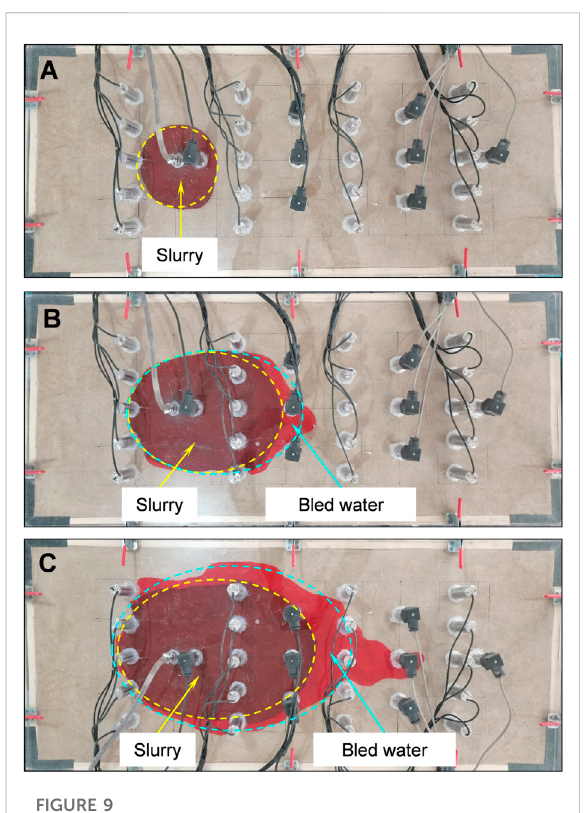
FIGURE 9 Distribution of slurry water bleeding. (A) Radial fast diffusion, (B) strike direction diffusion (early stage), and (C) Strike direction diffusion (later stage).